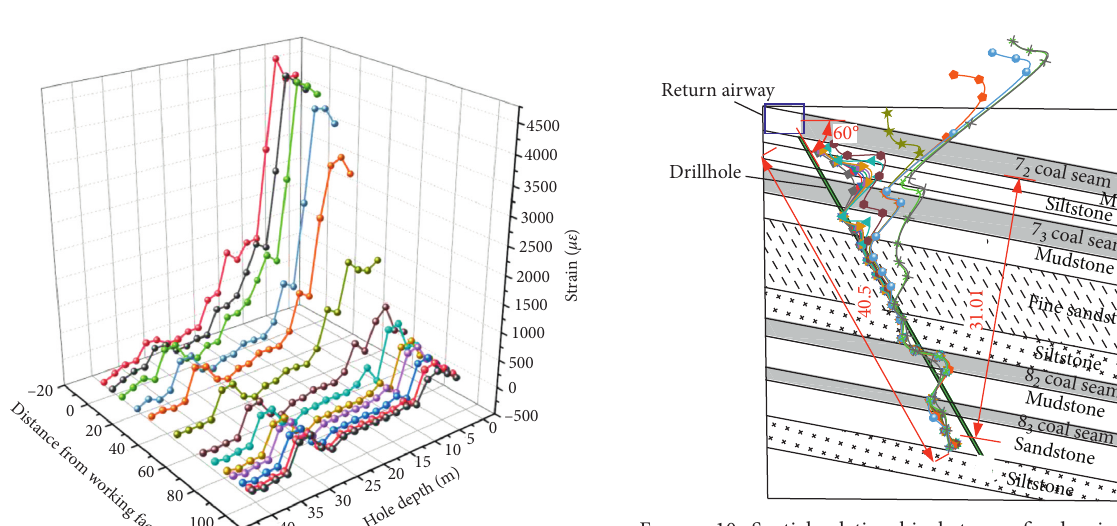
Figure 10: Spatial relationship between fixed-point grating and rock stratum.